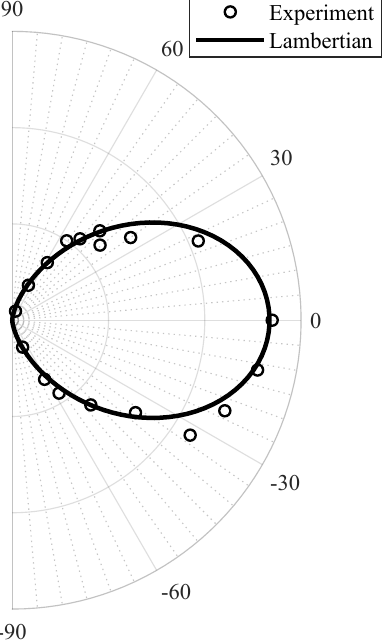
Figure 1. The fit of the Lambertian model with m =